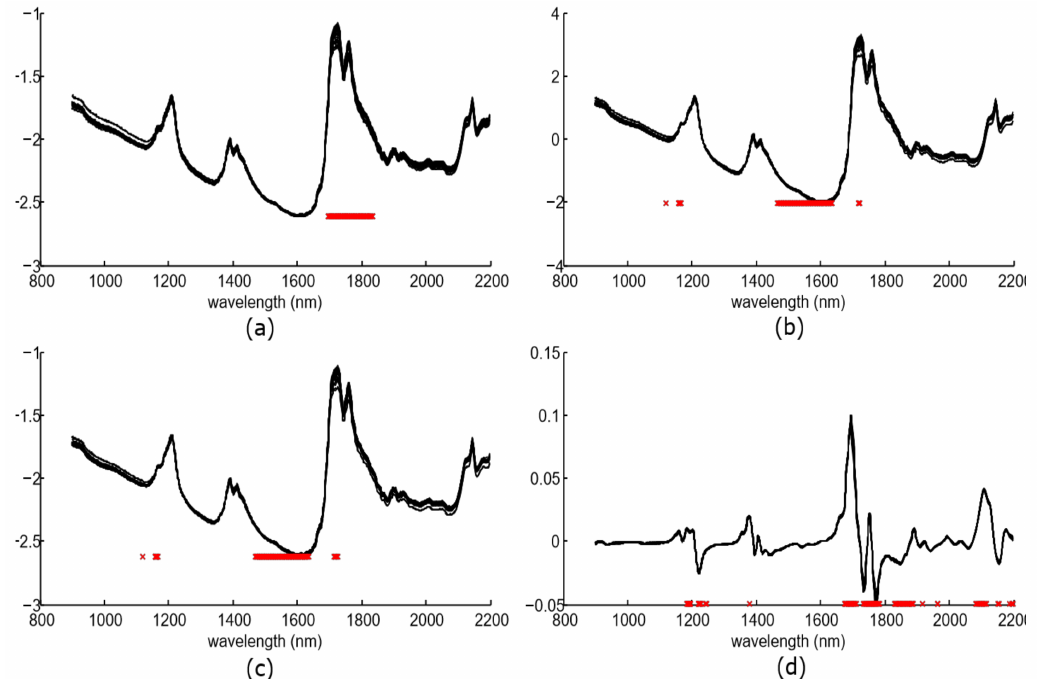
Figure 5. Figure shows the selected wavelengths after the filtering step (red marks) and the spectra of the whole dataset for each preprocessing algorithm: ( a ) without preprocessing, ( b ) standard normal